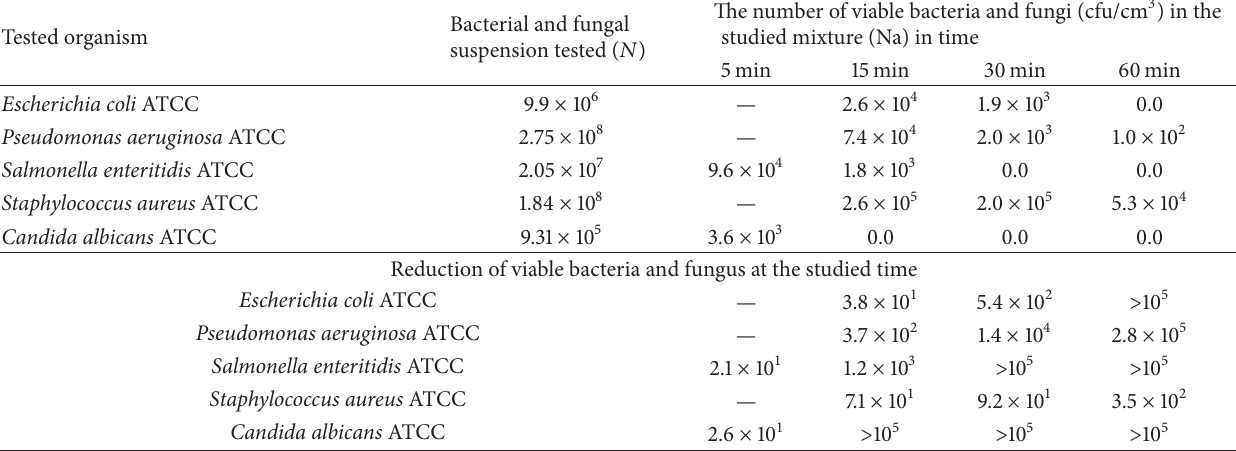
Table 6: Results of the evaluation using the dilution-neutralisation method for suspension number 6. Tested